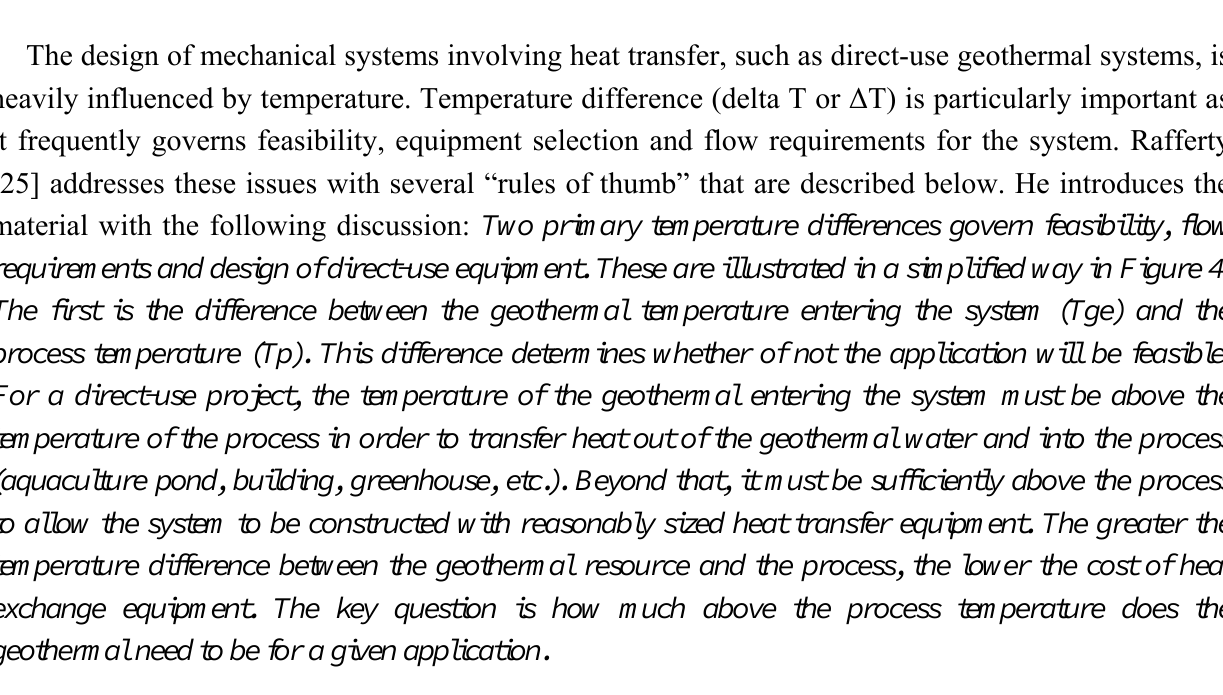
Figure 4. Fundamental direct-use temperature differences